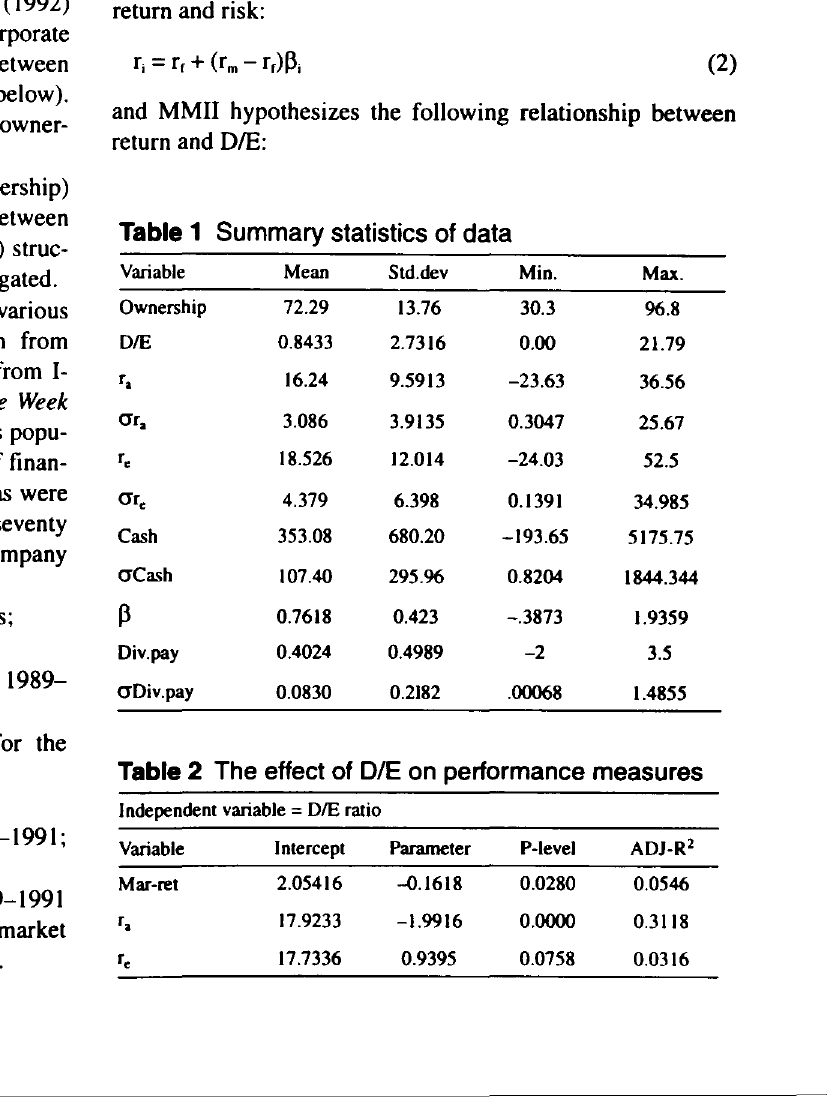
Table 2 The effect of D/E on performance